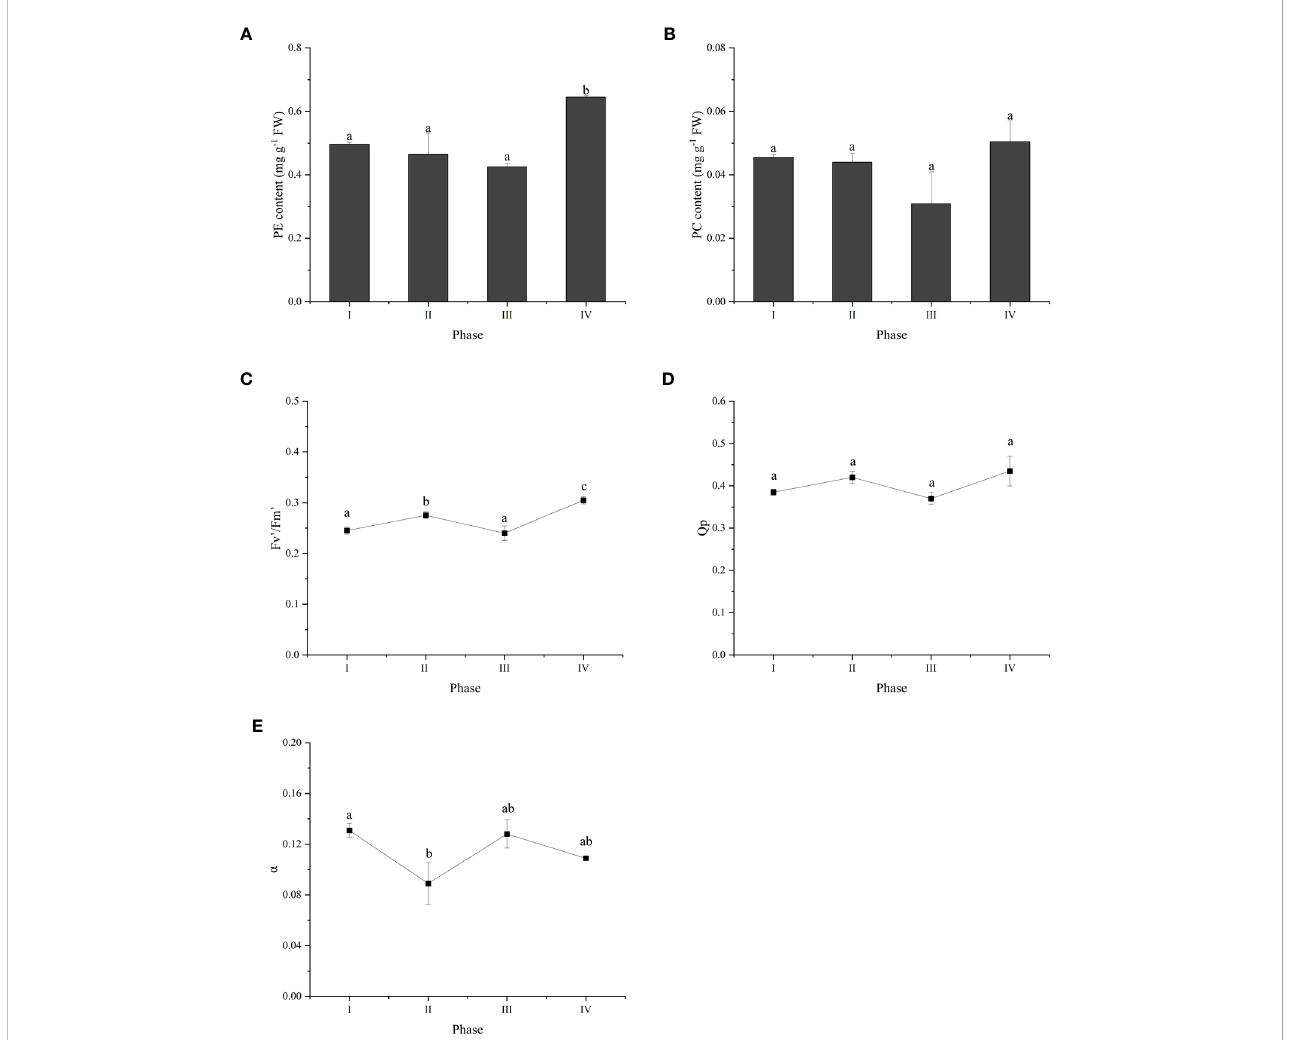
FIGURE 2 Overview of photosynthetic physiology parameters during tetraspore formation in G. lemaneiformis. (A) PE content; (B) PC content; (C) F v ’ /F m ’ ; (D) Qp; (E) a . Different letters indicate signi fi cant differences (p <